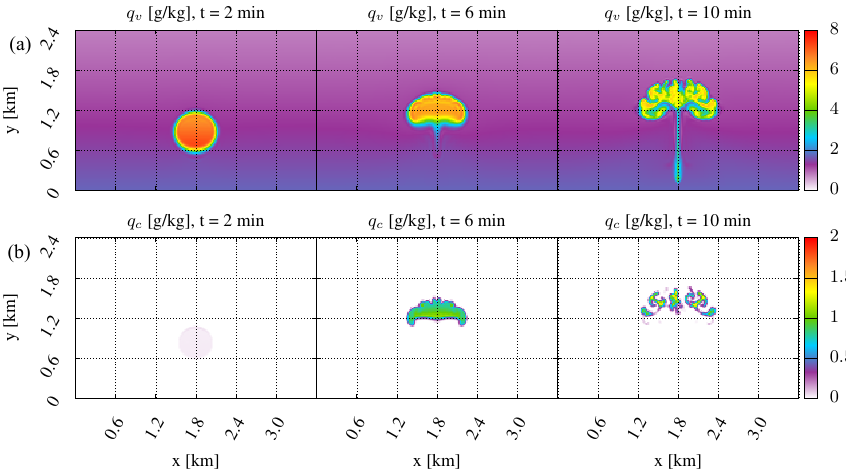
Figure 6. As Fig. 5, but for the UWLCM